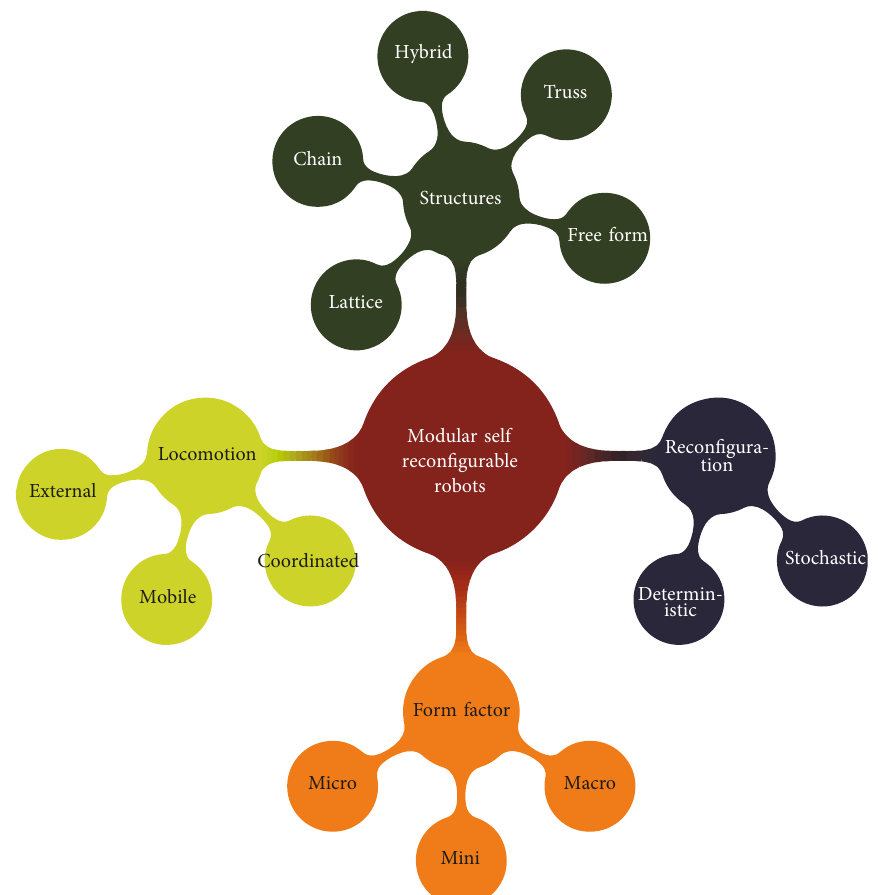
Figure 1: Classification of MSRR designs based on hardware